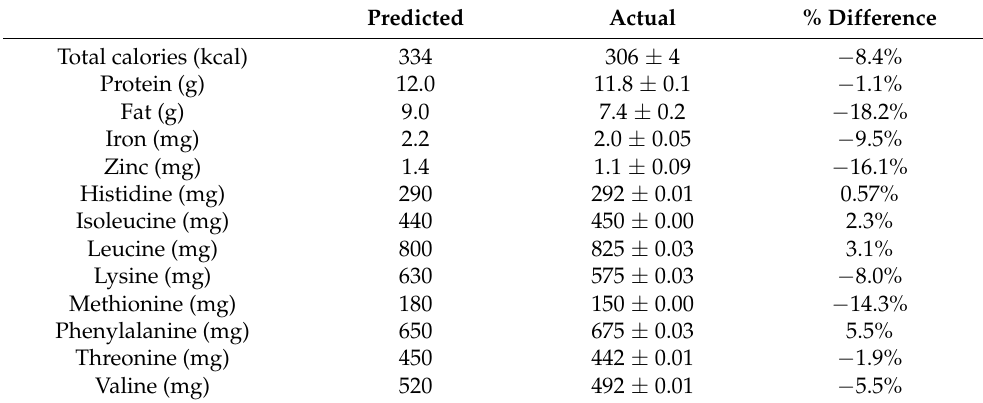
Table 2. Comparison of predicted versus actual nutrient content of final formulation after